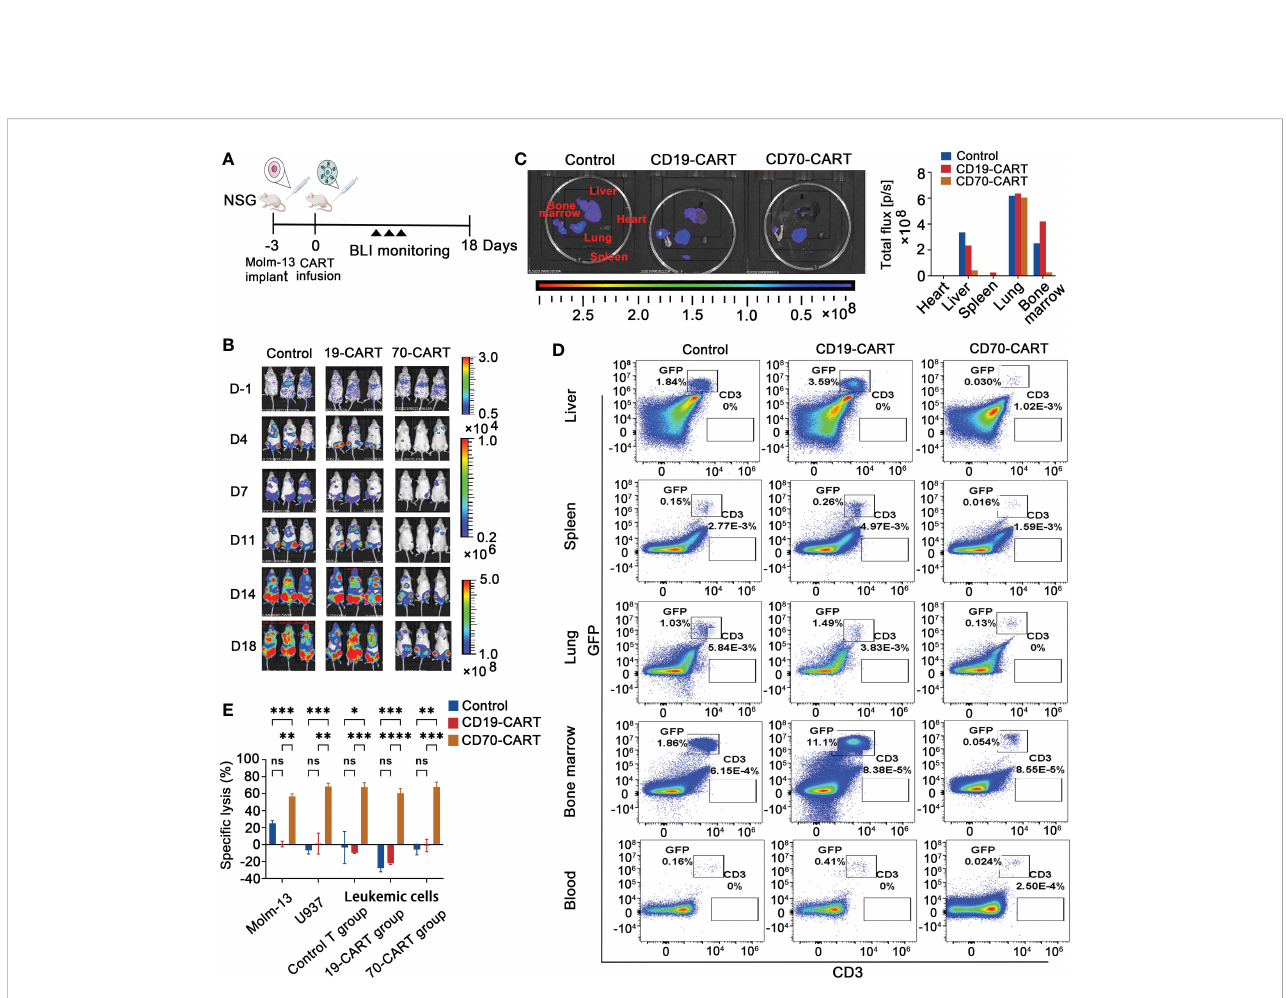
FIGURE 6 Evaluation of measurable residual disease (MRD) and CAR-T cell persistence in vivo . (A) , Scheme of in vivo experimental design. Leukemia bearing mice were also established using Molm-13 cells (1.0 × 10 5 ), which were treated with CAR T cells. Control T cells were used as control. (B) , Tumor burden was monitored using BLI. (C) , On day 18, mice (n=3) were killed, and heart, liver, spleen, lung and bone marrow (BM) were taken and followed with BLI to measure tumor burden, and then total fl ux in these organs were quanti fi ed. (D) , Suspension cells extracted from above organ except heart and peripheral blood of mice were analyzed for leukemia cells and CD3 positive T cells by fl ow cytometry. Representative results were shown. (E) , The leukemic cells, obtained from BM of mice that were treated CAR-T or control T cells, were cultured for 3 days, and then were co-cultured with control T, and CAR-T cells at E:T ratio of 10:1 for 4 h. Molm-13 and U937 cell lines were used as control. Killing of leukemic cells by CD70-CAR-T cells as determined by luciferase-based cytotoxicity assay. One-way ANOVA, post hoc using Tukey ’ s test. * P <0.05, ** P <0.01, *** P <0.001, **** P <0.0001, ns means no signi fi cance.